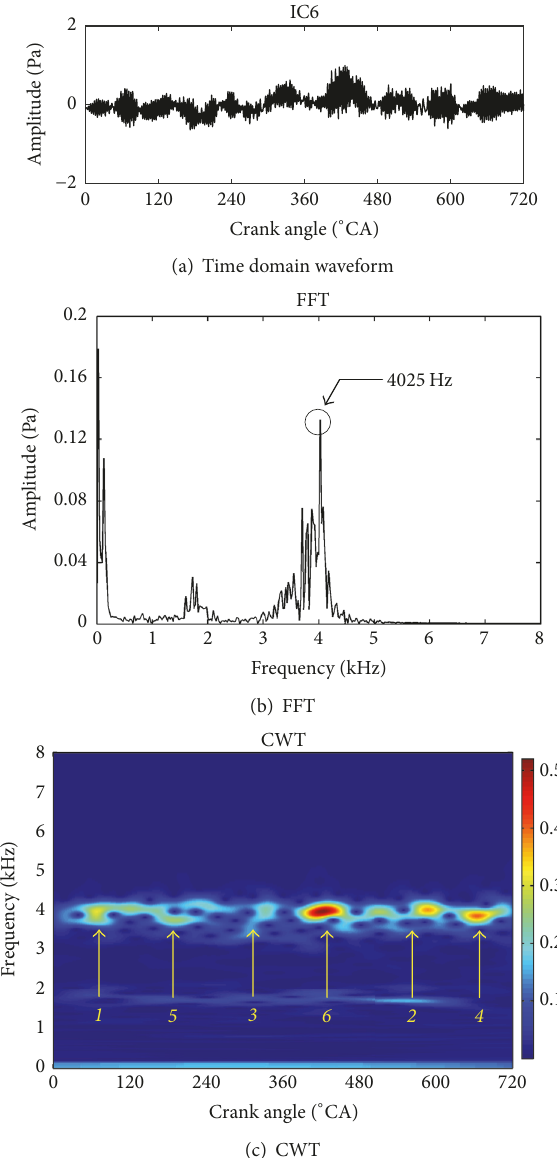
Figure 14: Time domain waveform, FFT, and CWT of IC6 by the Gammatone-RobustICA